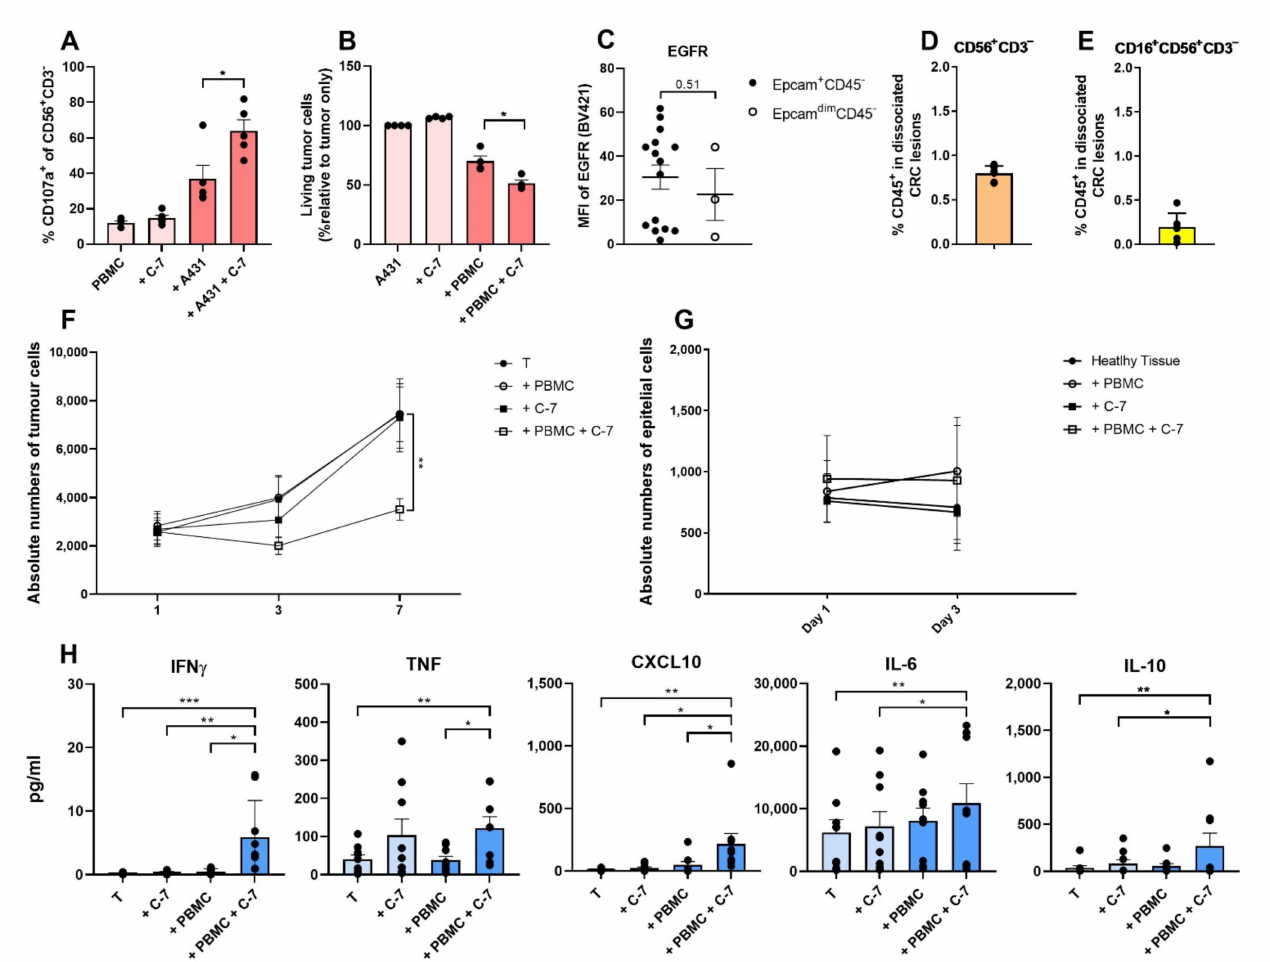
Figure 6. Activity of the bispecific C-7 VHH using metastatic CRC patient-derived PBMC and dissociated tumor samples. ( A ) Degranulation of NK cells (defined as CD45 + CD56 + CD3 − cells) and ( B ) cytotoxicity of A431 tumor cells after a 4-h (degranulation) and 24-h (cytotoxicity) co-culture of monocyte-depleted PBMC derived from patients with stage II/III CRC pre-activated overnight with IL-2 and IL-15 ± A431 (EGFR ++ ) ± 100 nM C-7. E:T ratio 4:1. Degranulation was determined by assessing the percentage of NK cells expressing CD107a + . Cytotoxicity was determined by assessing the relative percentage of living tumor cells compared to the tumor-alone control. n = 5 ( A ), n = 4 ( B ). ( C ) EGFR MFI of Epcam + CD45 − tumor cells in dissociated CRC peritoneal metastatic lesions ( n = 15) and Epcam dim CD45 − epithelial cells, in (non-malignant) peritoneal tissue ( n = 3). CD56 + CD3 − ( D ) and CD16 + CD56 + CD3 − ( E ) percentage of CD45 + cells in dissociated CRC peritoneal metastatic lesions, n = 6. ( F ) Absolute number of Epcam + CD45 − tumor cells from dissociated CRC peritoneal metastatic lesions cultured ± autologous PBMC (E:T ratio 5:1) ± 100 nM C-7 for 1, 3, and 7 days. n = 8. The significance level refers to the conditions: “T+PBMC” versus “T+PBMC+C-7”. ( G ) Absolute number of Epcam dim CD45 − cells from dissociated normal (non-malignant) peritoneal tissue of patients with metastatic CRC ± autologous PBMC (E:T ratio 5:1) ± 100 nM C-7, incubated for 1 and 3 days. n = 3. ( H ) Cytometry Bead Array performed on supernatant of dissociated CRC peritoneal metastases cultured for 24 h ± autologous PBMC (E:T ratio 5:1) ± 100 nM C-7. n = 9. The data are presented as mean ± SEM. Significance is presented as p < 0.05 *, <0.01 **, <0.001 ***. No p -values are mentioned in case p > 0.05. p -values are determined by two-tailed paired t -test ( A , B ); Mann–Whitney test ( C ); two-way ANOVA with Dunnett’s multiple comparison test ( F , G ); one-way ANOVA with Dunnett’s multiple comparison test (H: IL-6); Friedman test with Dunn’s multiple comparison test ( H : IFN γ , TNF, CXCL10, IL-10). Abbreviations: T = tumor, C-7 = C21-7D12 bispecific VHH, PBMC = peripheral blood mononuclear